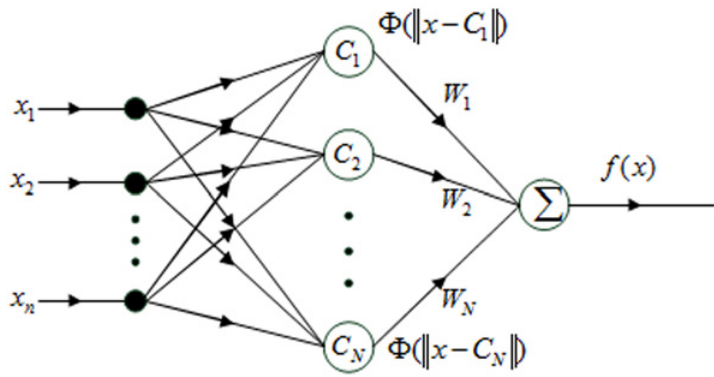
Fig 1. The architecture of RBFNN. x = [ x 1 , x 2 , (cid:1)(cid:1)(cid:1) , x n ] is n-dimensional input vector, C i ( i = 1,2, (cid:1)(cid:1)(cid:1) , N ) is the center of transformation function Φ ( x ), W = [ W 1 , W 2, (cid:1)(cid:1)(cid:1) , W N ] is the weight between the hidden layer and output layer.